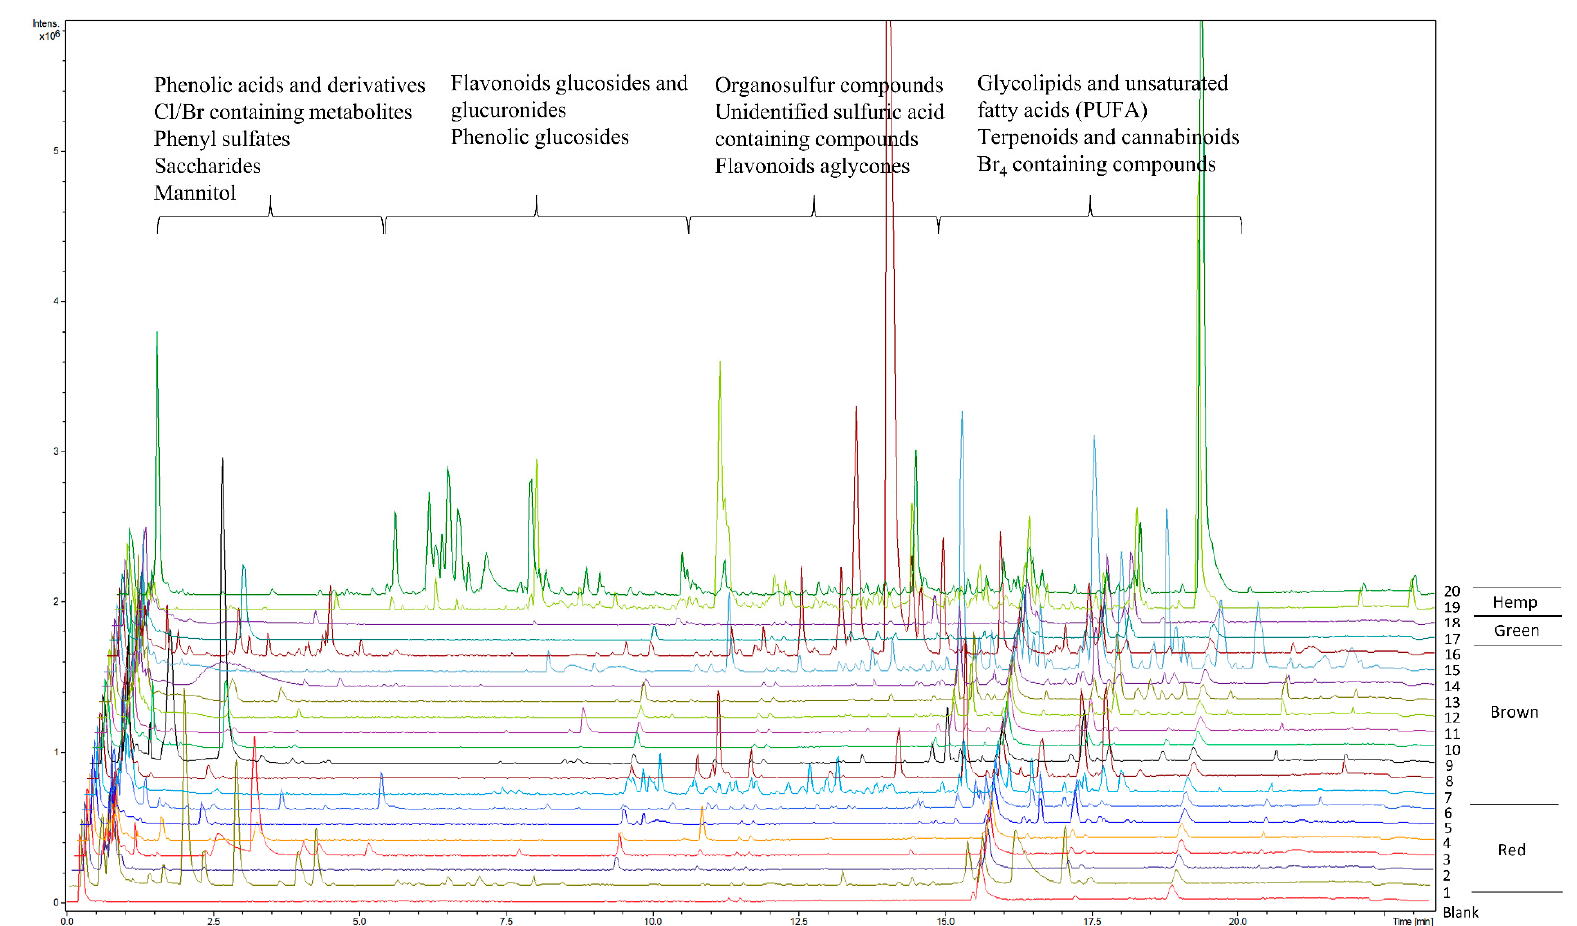
Figure 2. Metabolic profiles of red, brown and green seaweeds and hemp of the Extract 2 group, measured using untargeted LC-MS. Blank sample represents the extraction solvent used for the extraction of metabolites in samples. Red seaweeds: (1) Asparagopsis taxiformis , (2) Chondrus crispus , (3) Furcellaria lumbricalis , (4) Polyides rotundus , (5) Dumontia contorta , (6) Delesseria sanguinea . Brown seaweeds: (7) Saccharina latissima , (8) Gracilaria vermiculophylla , (9) Fucus serratus , (10) Fucus spiralis , (11) Fucus evanescens , (12) Alaria esculenta , (13) Laminaria digitata , (14) Chorda filum , (15) Dictyota dichotoma , (16) Sargassum muticum . Green seaweeds: (17) Ulva intestinalis , (18) Ulva sp. Hemp: (19) Cannabis sativa L. variety Finola, (20) Cannabis sativa L. variety Futura 75.